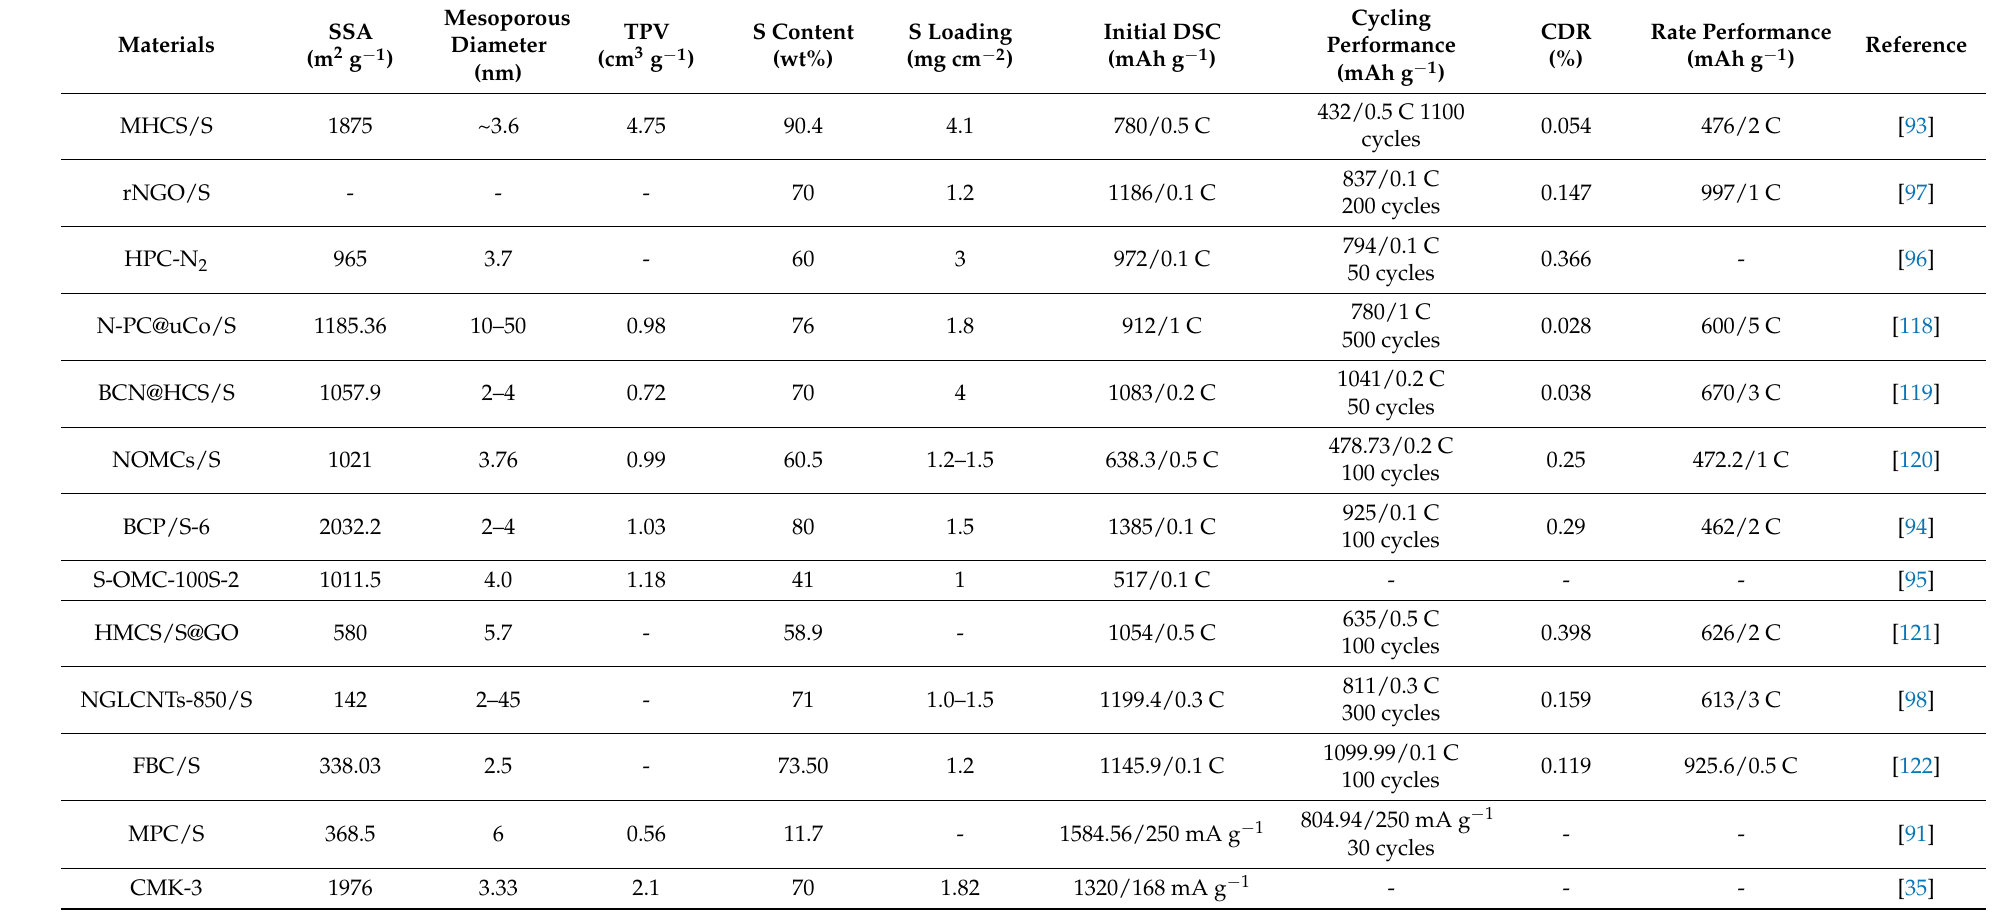
Table 1. A summary of the properties and LSBs performance of MCBM/S